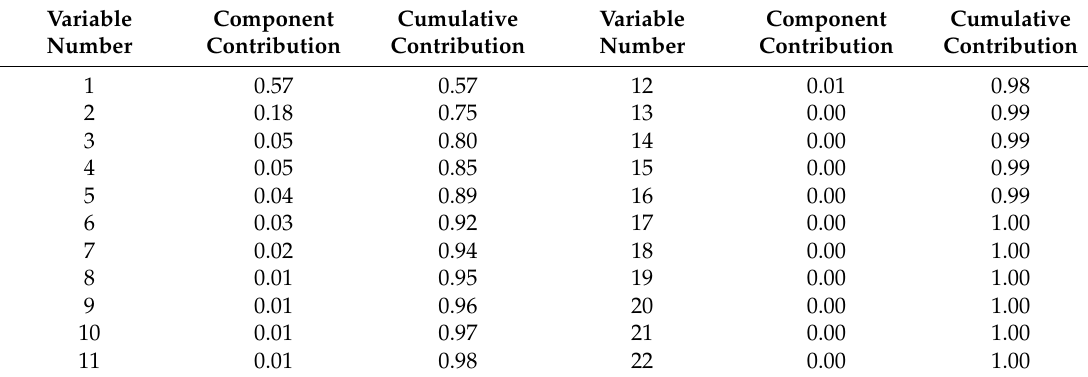
Table 2. Contribution